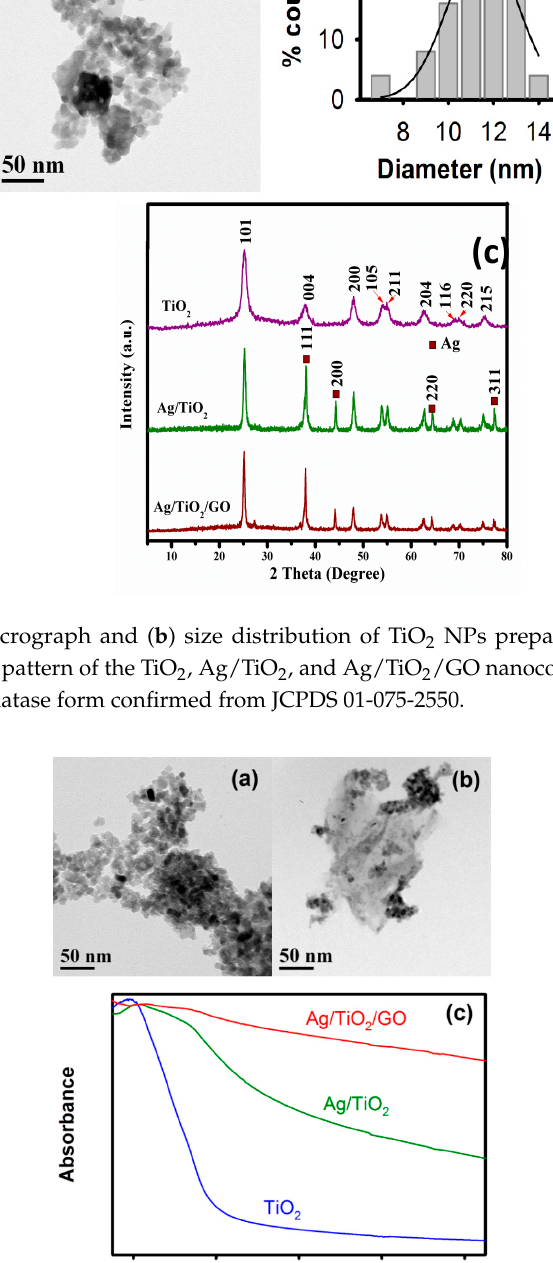
Figure 3. TEM micrographs of ( a ) Ag/TiO 2 and ( b ) Ag/TiO 2 /GO samples. ( c ) UV/visible optical absorption spectra of TiO 2 , Ag/TiO 2 , and Ag/TiO 2 /GO samples in water (concentration: 0.1 g/L).